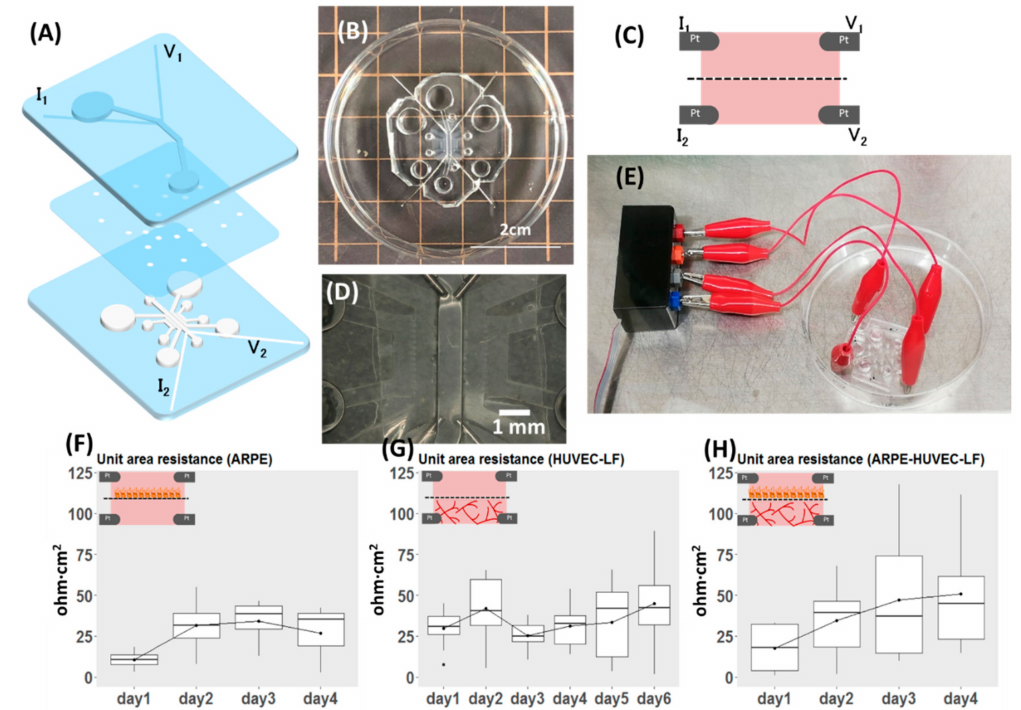
Figure 4. Demonstration of the versatility of the proposed design, with modification for measuring TEER. ( A ) Exploded view of the device. ( B ) Top view of the assembled device. ( C ) Schematic view of the cross-section showing the position of voltage and current electrodes. ( D ) Magnified view of ( B ) focusing on the position of electrodes inside the device. ( E ) Part of the system set-up showing the connection of the device to the electrode adapter, which is connected to the EVOM instrument for TEER measurement. ( F – H ) Results of TEER measurement reported as unit area resistance. The inset for each plot shows what was measured of ( F ) TEER of ARPE monolayer (n = 4). ( G ) TEER of co-culture of HUVEC and NHLF (n = 10). ( H ) TEER of the oBRB model (n =